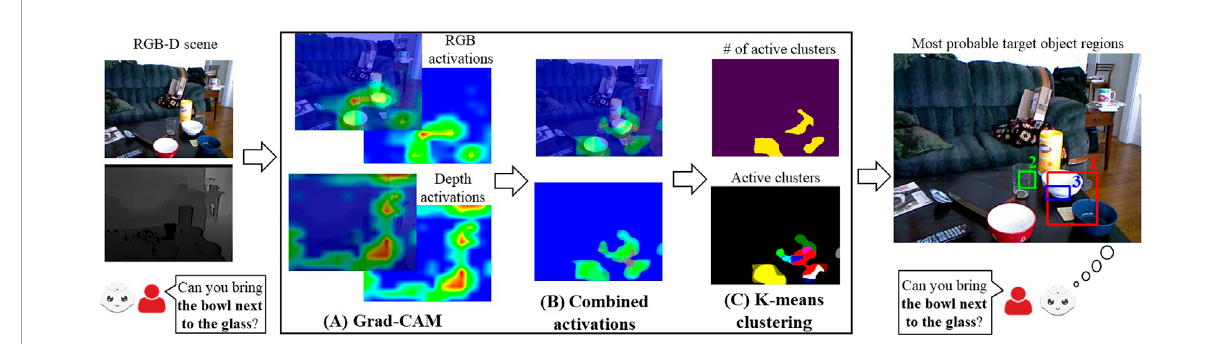
FIGURE 5 For a given RGB-D scene and a referring expression (i.e., the bold part of the user expression), the overview of the Grad-CAM RGB-D method to obtain the bounding boxes containing the target object regions. The RGB and depth heatmaps generated by Grad-CAM in (A) , combined activations in (B) , and the results from K-means clustering in (C) .